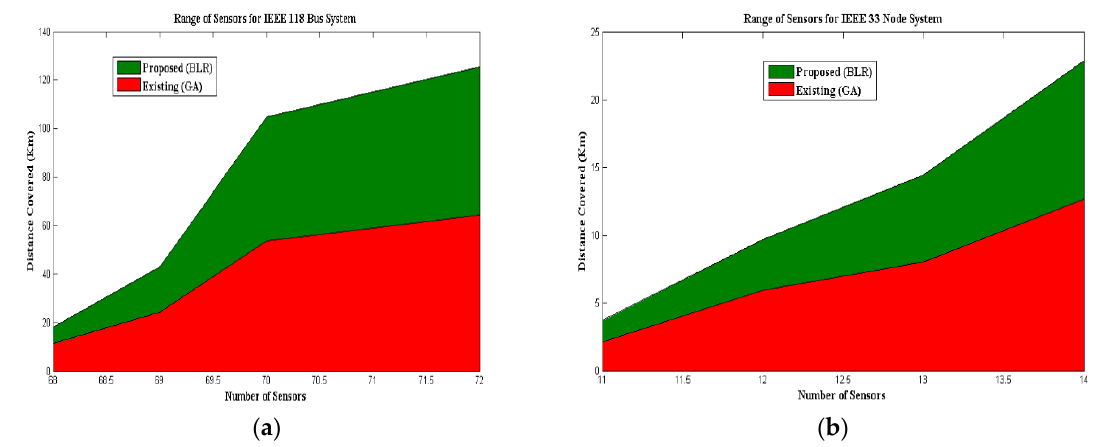
Figure 4. Distance covered by sensors for test systems: ( a ) IEEE 118 bus; and ( b ) IEEE 33 node.